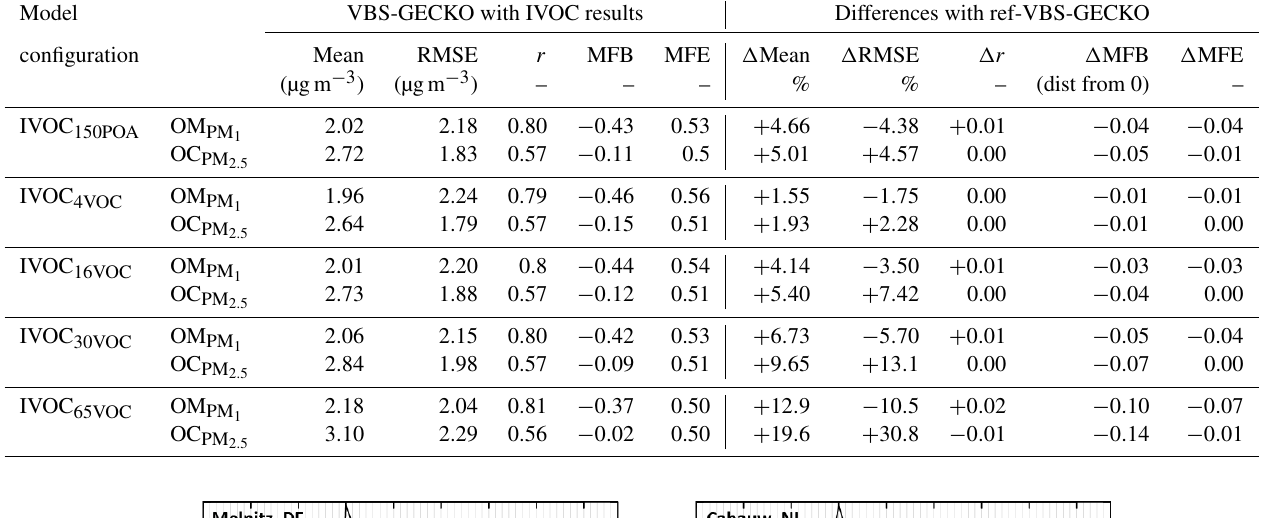
Table 6. Statistical results calculated on daily averaged concentrations simulated with VBS-GECKO considering IVOC emissions and dif- ferences with those of the ref-VBS-GECKO (without IVOCs) from Table 3. Model VBS-GECKO with IVOC results Differences with ref-VBS-GECKO configuration